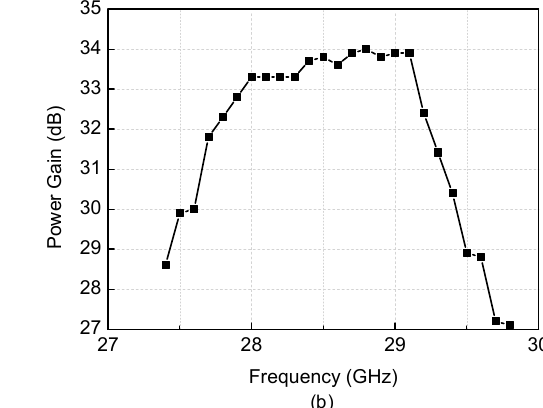
Figure 11. Measured results. ( a ) Input ‐ to ‐ output power transfer characteristics. ( b ) Power gain over the operating frequency.